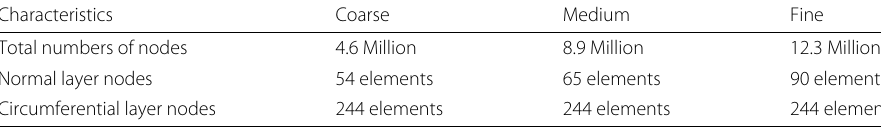
Table 2 Characteristics of the different resolutions of the grids Characteristics Coarse Medium Fine Total numbers of nodes 4.6 Million 8.9 Million 12.3 Million Normal layer nodes 54 elements 65 elements 90 elements Circumferential layer nodes 244 elements 244 elements 244